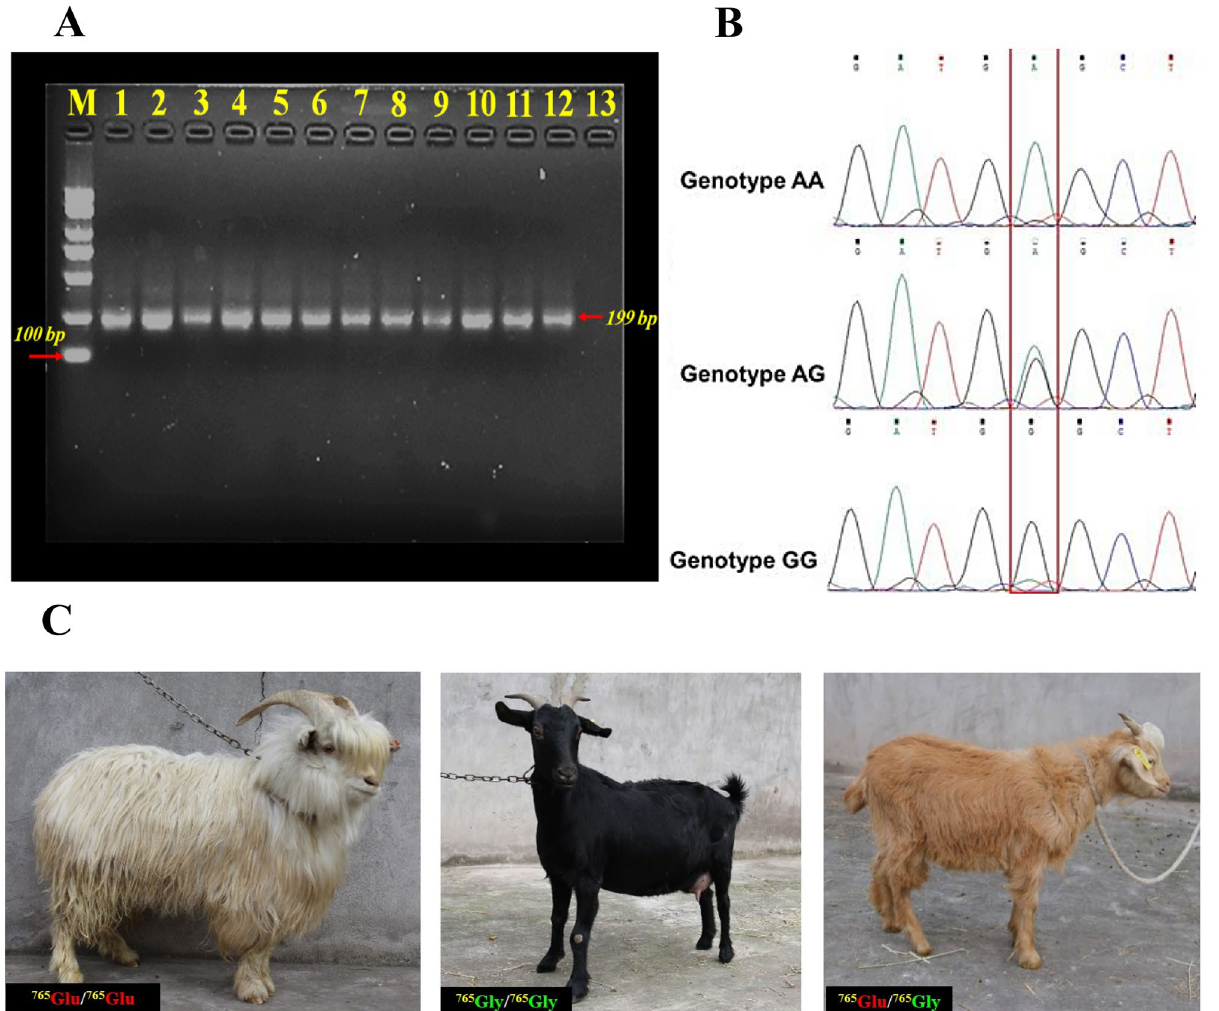
Figure 6. ( A ) PCR amplification (electrophoretogram) of Kit gene (rs647214940 site), Lanes: 1 to 4 for Inner Mongolia cashmere (IMCG), lanes: 5 to 8 for Dazu black goat (DBG), and lanes: 9 to 12 for IMCG x DBG cross (F 1 ), M: 100 bp DNA ladder. ( B ) Sanger sequencing result for Kit gene (rs647214940 site) and ( C ) The non- synonymous mutation g. 68354798G>A (rs647214940 site) led to 765 glutamic (Glu)/ 765 glycine (Gly) (off white to light brown coat colour) in first cross (F 1 ), while was 765 Glu/ 765 Glu (white coat colour) in Inner Mongolia Cashmere goat (IMCG), and was 765 Gly/ 765 Gly (black coat colour) in Dazu Black goat